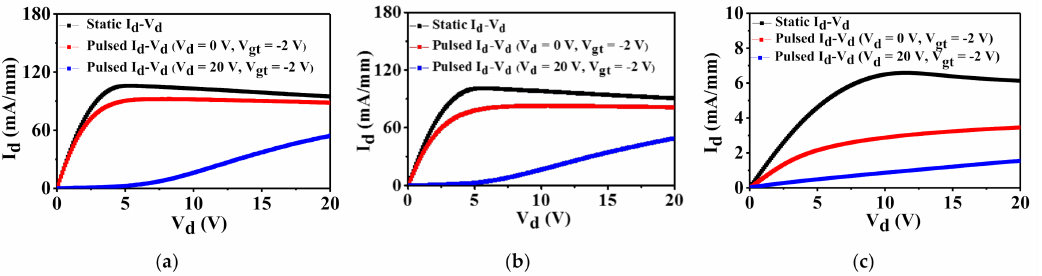
Figure 4. Static and pulsed I d − V d characteristics for AlGaN/GaN HEMTs with ( a ) in situ SiCN cap layer, ( b ) in situ SiN cap layer, and ( c ) without cap layer at V g = 1 V and V d = 0~20